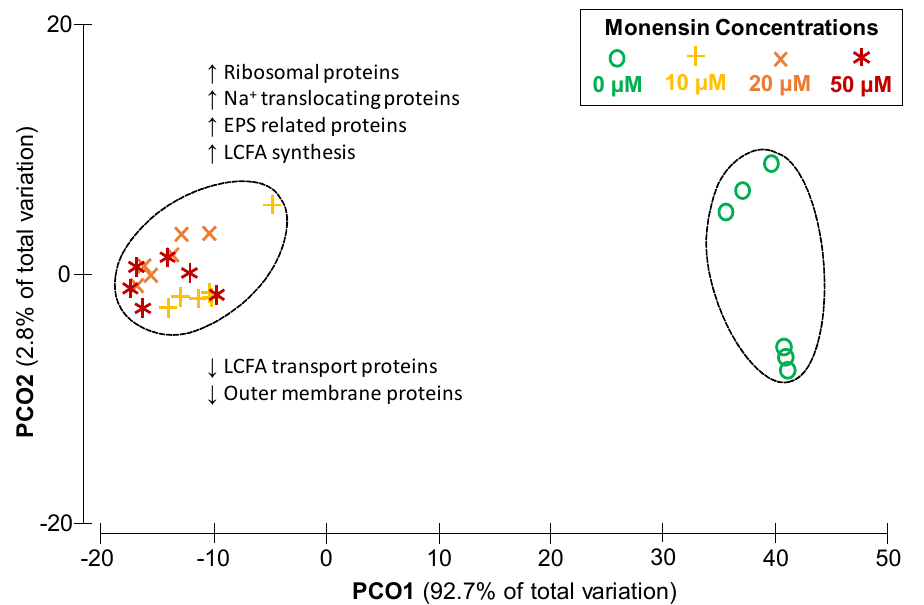
Figure 4. Changes of P. bryantii proteomes at different monensin conditions. Each condition consisted of six replicates ( n = 6). Principal component analysis with 1686 label-free quantified proteins resulted in two clusters of 80% similarity dividing in with (left) and without monensin (right). Monensin concentrations are depicted in green (0 µM), yellow (10 µM), orange (20 µM), and red (50 µM). Arrows with functional assignation indicate a high ( ↑ ) or low ( ↓ ) abundance of mentioned functional protein groups.